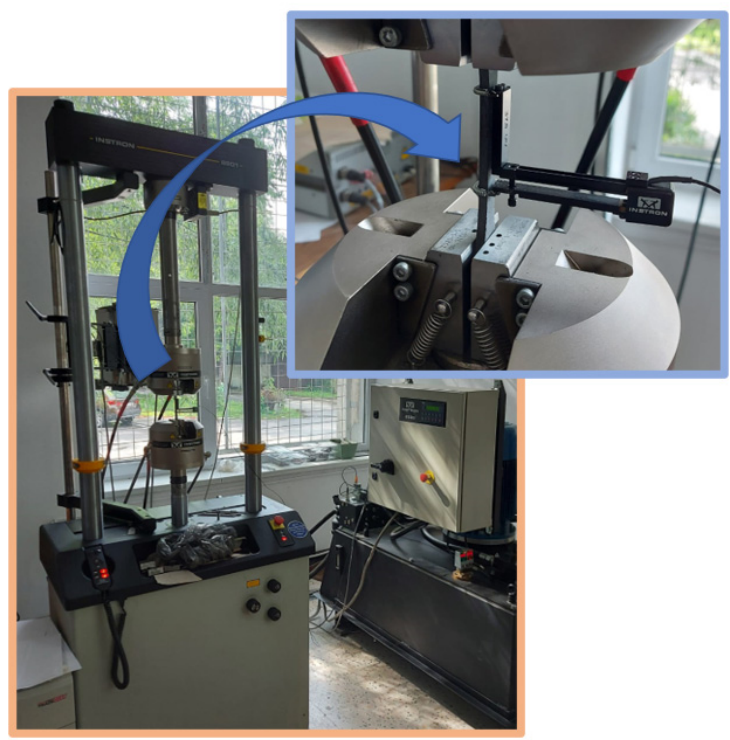
Figure 4. Tensile testing of multi-ply CFRP.